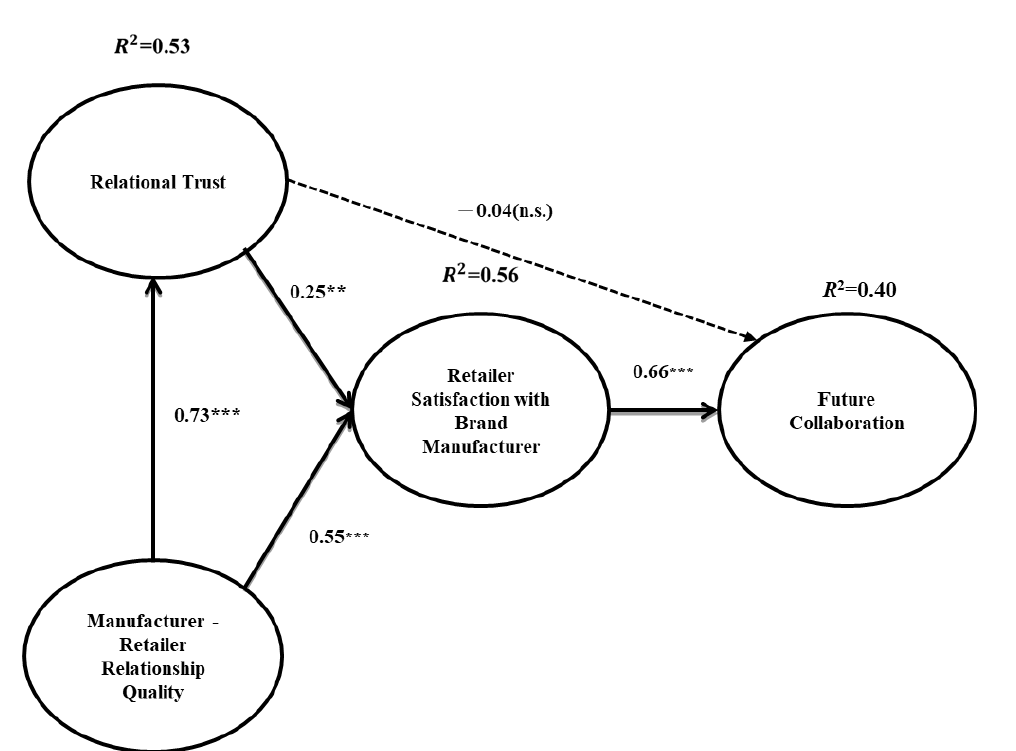
Figure 2. Structural equation model of hypotheses testing result. ** p < 0.01; *** p < 0.001. Table 8. The results of the structural equation model. Proposed Path Hypothesis Result Effect Coefficient